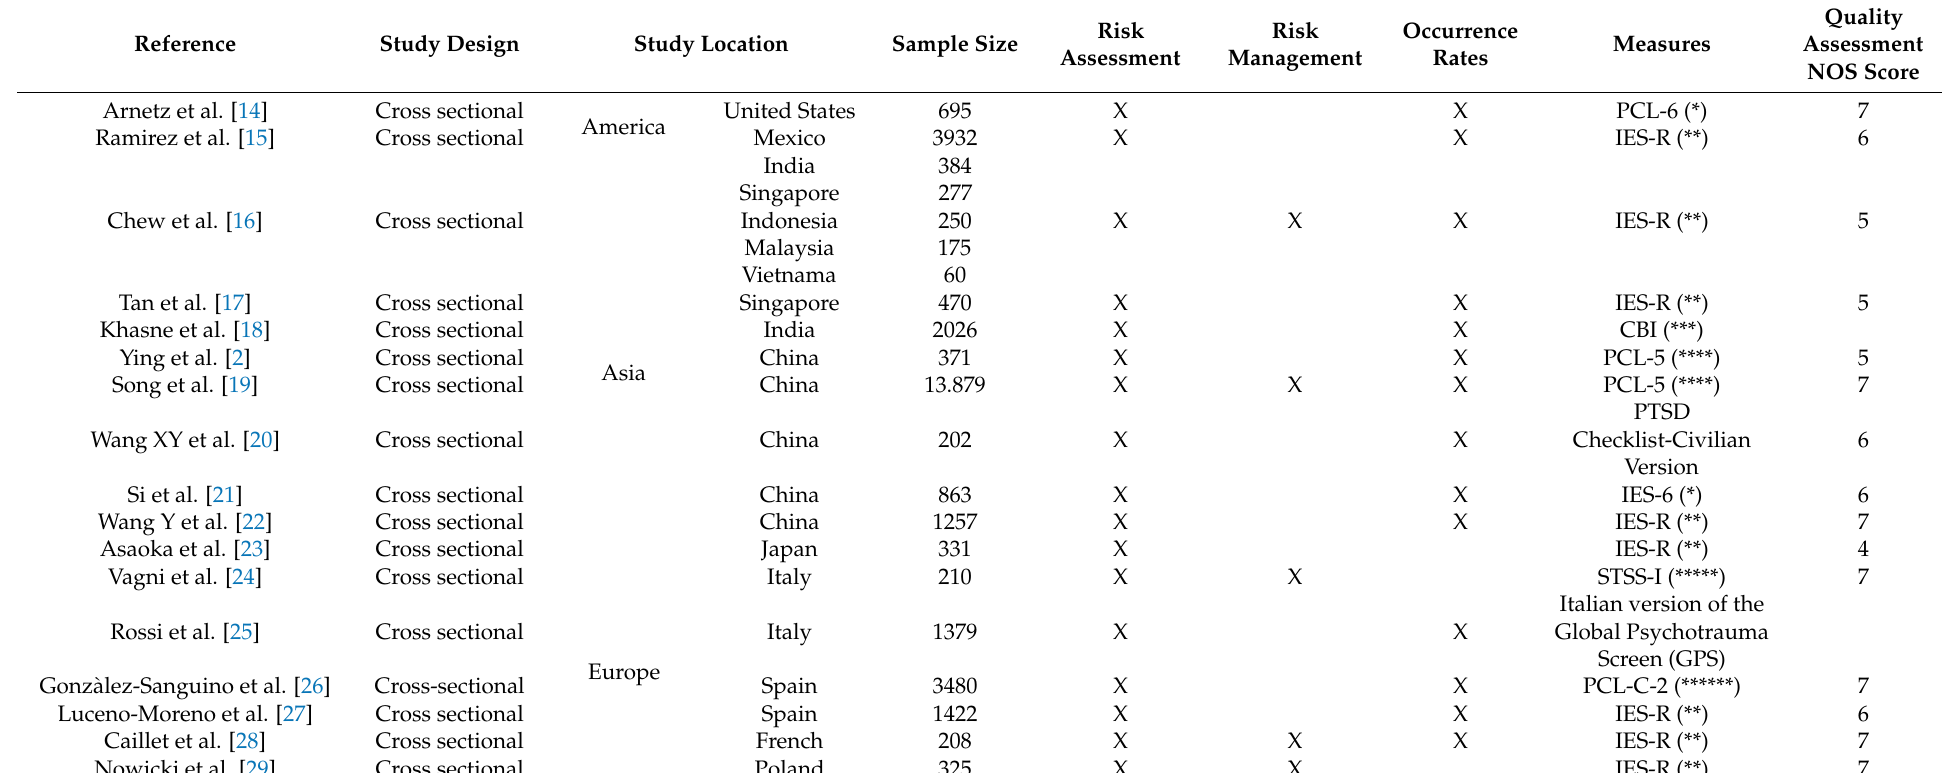
Table 1. Summary of the studies included in the